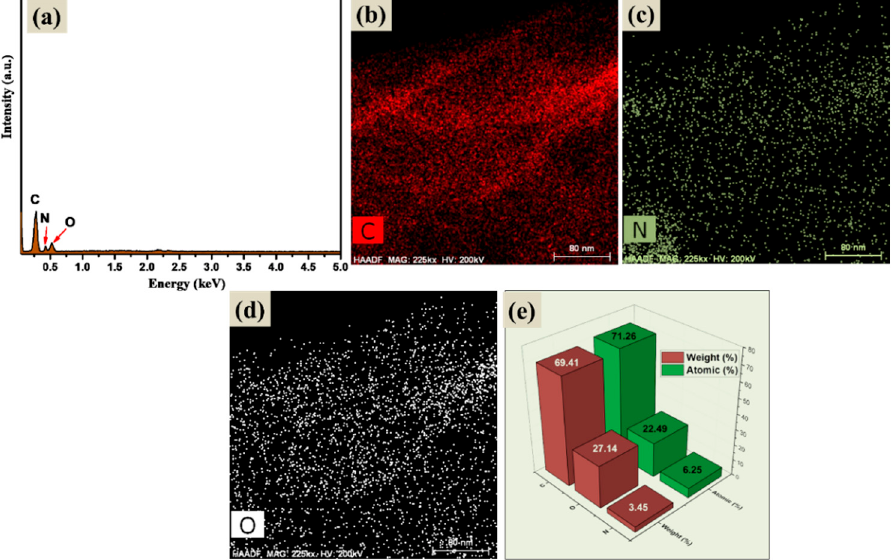
Figure 4. The EDX spectrum ( a ), EDX mapping images ( b – d ), and elemental composition ( e ) of N-rGO.